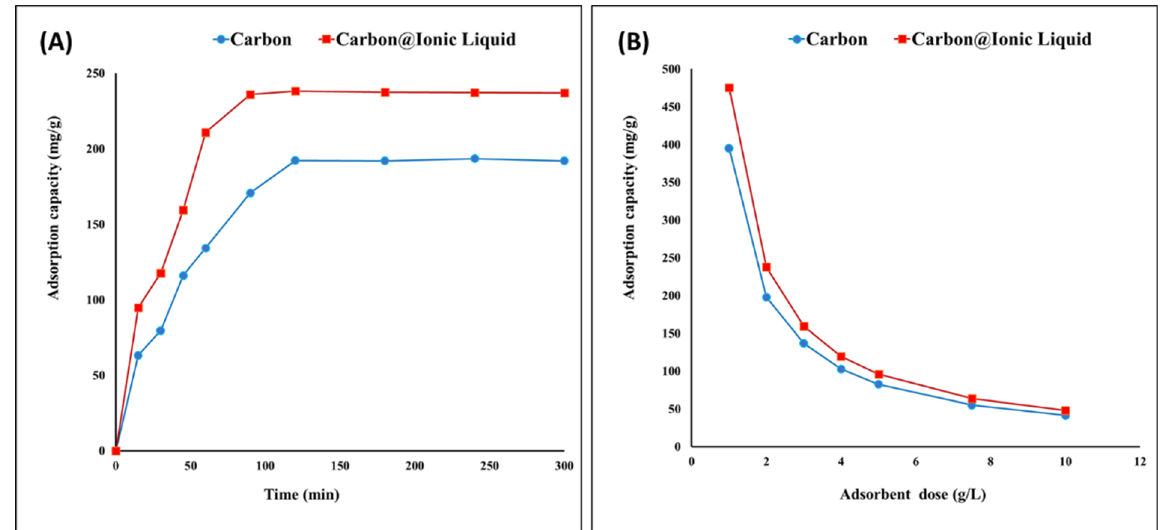
Figure 4. Adsorption of benzothiophene onto carbon and trihexYl(tetradecyl)phosphonium dicyanamide-modified renewable carbon: effect of contact time ( A ) and effect of adsorbent dose ( B ).